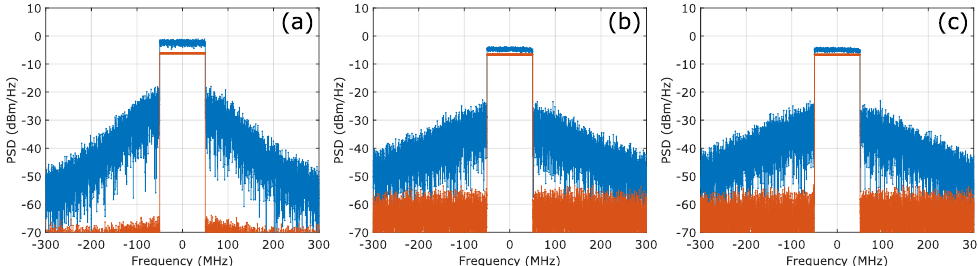
Figure 10. Spectra of the output RF signal before (blue lines) and after linearization (red lines) with PA parameters at ( a ) nominal values, ( b ) after coordinate descent (iterated) optimization, and ( c ) after Bayesian optimization (P4).